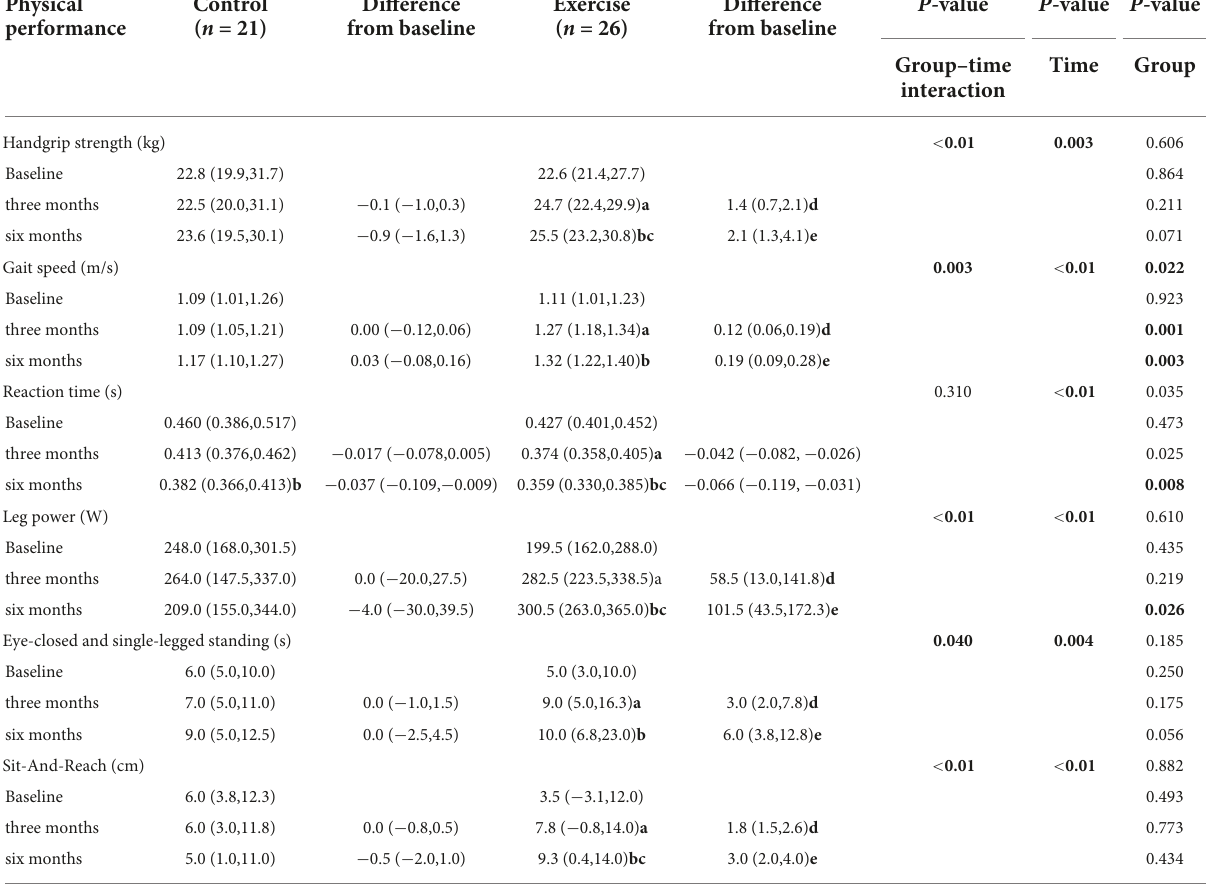
TABLE 4 Effect of Yijinjing combined with resistance exercise on physical performance in the study’s participant. Physical